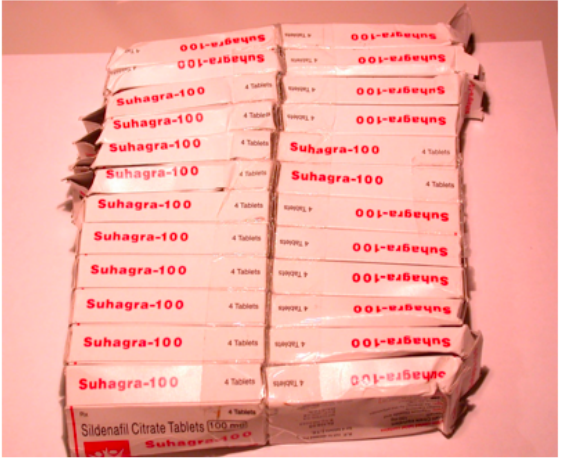
Of the 41 drug products, 36 did not meet criteria for prescription drug labeling, and 39 did not meet criteria for prescription drug containers and packaging as required in the United States. For all international products, the only drug products that met US standards for labeling were those from Canada. Only 1 container from Canada and 1 container from Mexico met US